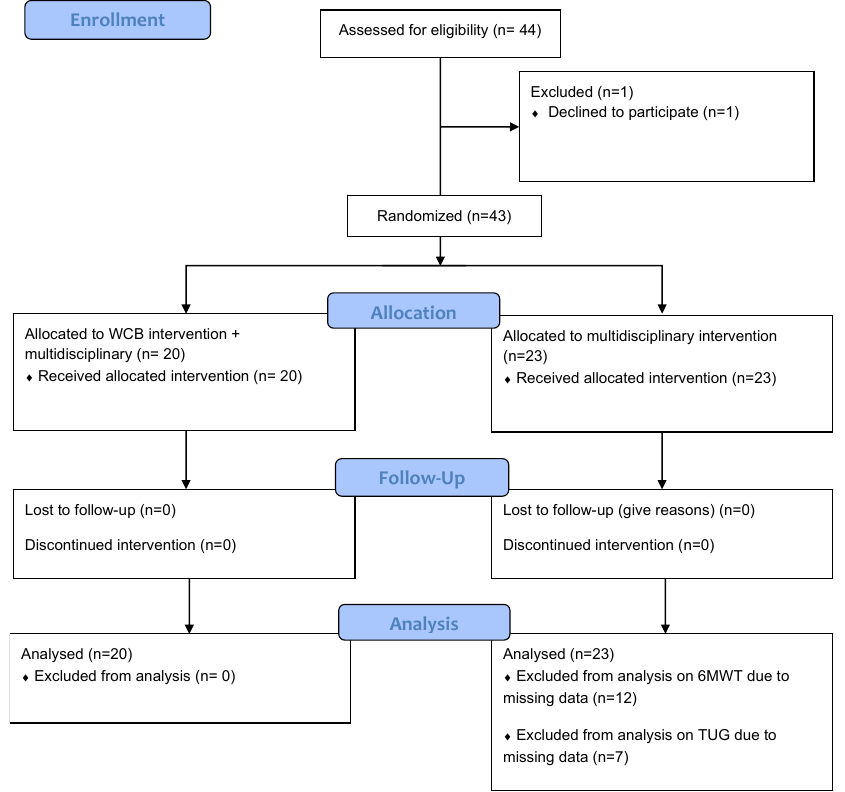
Figure 1. The CONSORT flow chart describing each stage of the study: enrollment, allocation, intervention exposure, follow-up, and analysis.